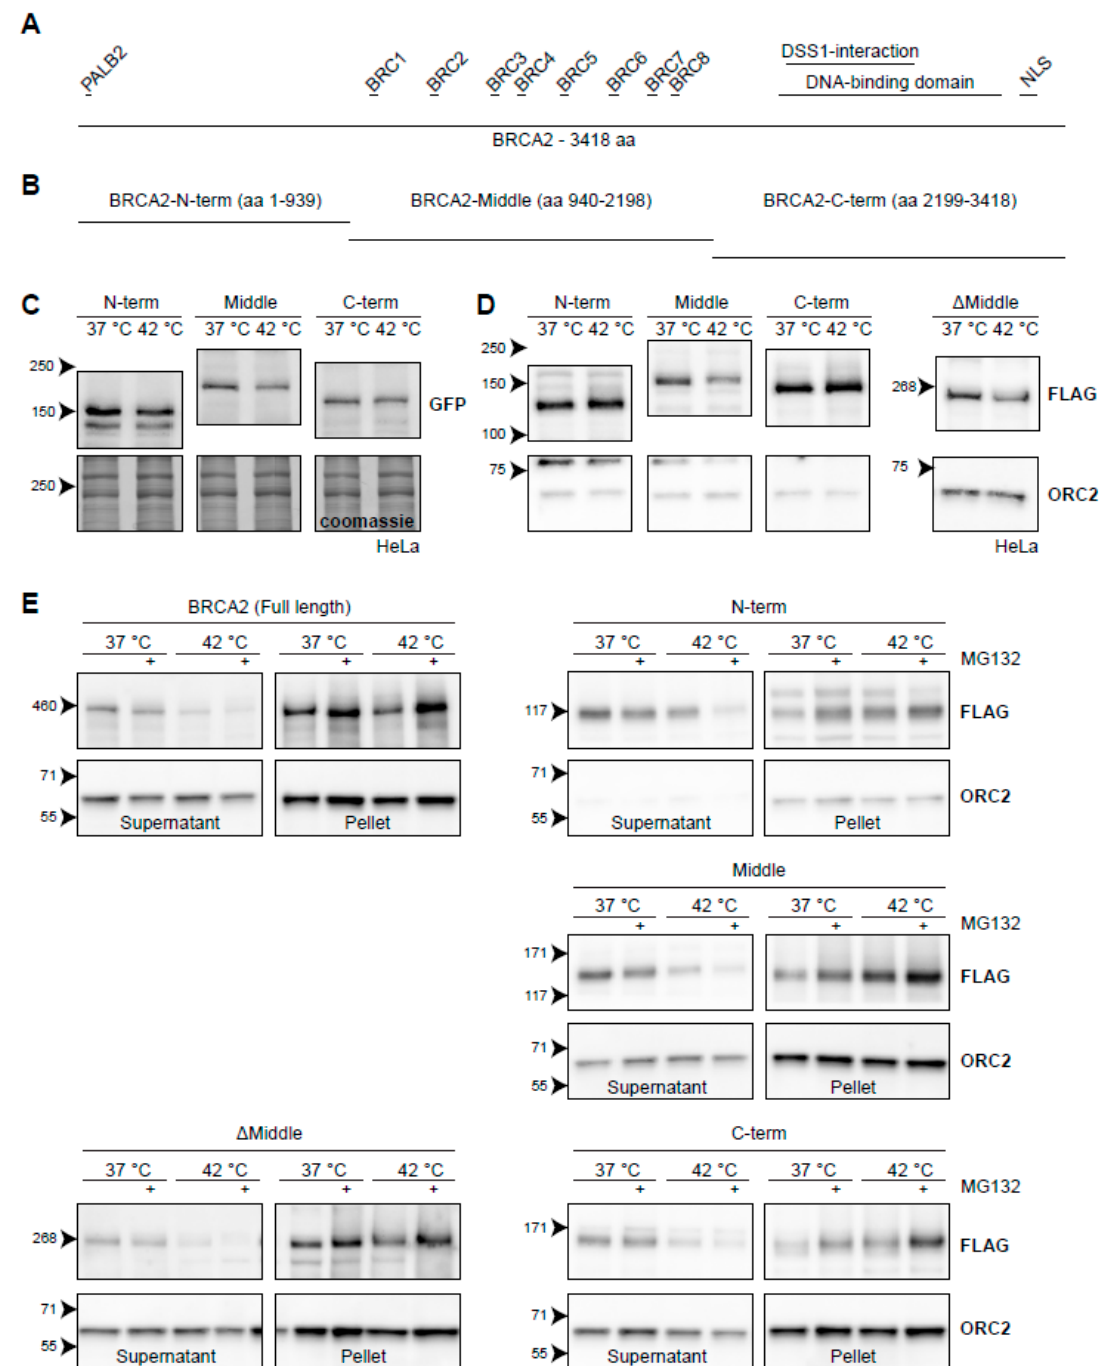
Figure 6. BRCA2 degradation upon heat treatment from the perspective of BRCA2. ( A ) Graphical representation of the full-length 3418-aa BRCA2-protein. Interaction domains are indicated as small bars above the full-length protein. ( B ) Arbitrary truncations of the BRCA2-protein to be tested for heat stability. ( C ) HeLa cells stably expressing GFP-BRCA2 fragments. ( D ) HeLa cells stably expressing FLAG-BRCA2 fragments. The right panel contains a FLAG-tagged Δ Middle construct, which effectively is a fusion of the constructs designated as the N and C-termini. ( E ) Hela cells expressing the different constructs were subjected to hyperthermia in the absence or presence of 50 µM MG132 and processed following a fractionation protocol prior to lysis. The resulting supernatant and pellet fractions are shown.